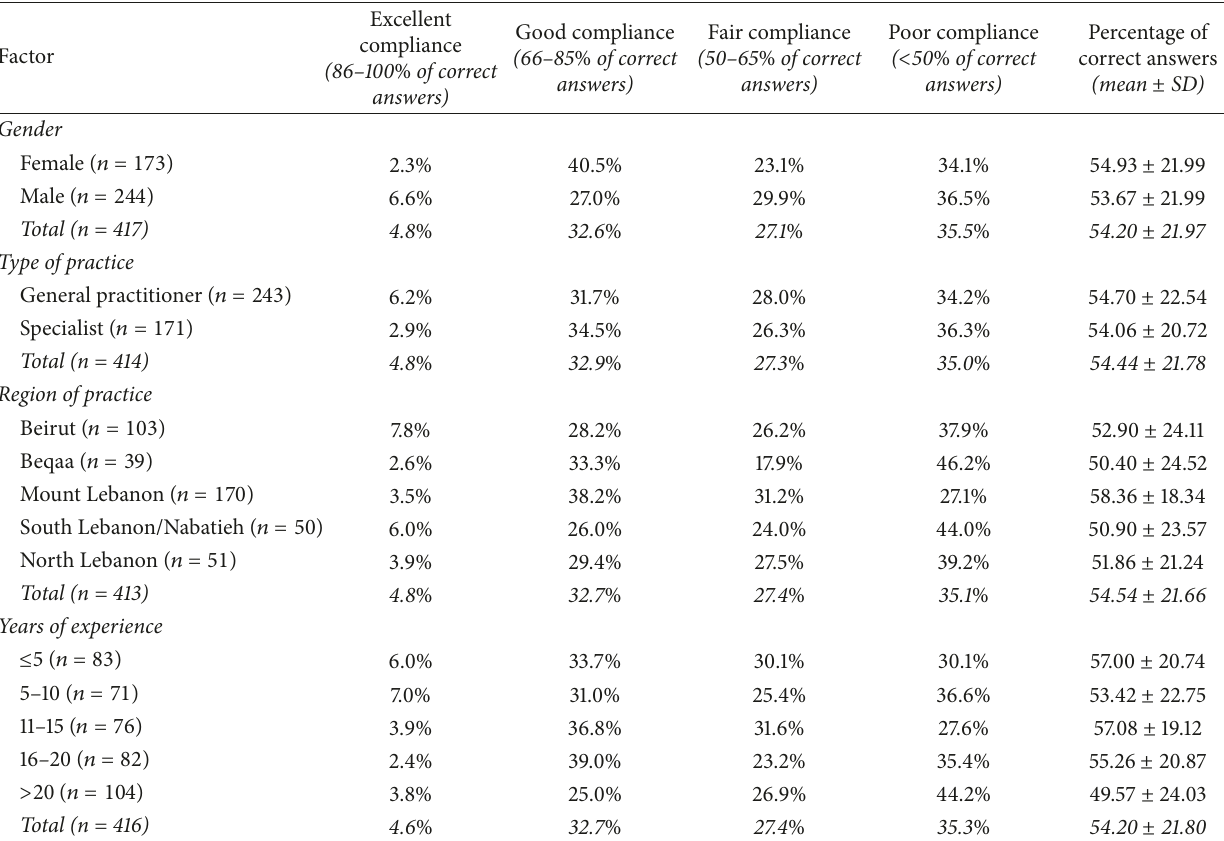
Table 5: Levels of compliance with infection control practices in private dental clinics in Lebanon (2015) according to sociodemographic variables and work experience. The level of compliance is expressed as excellent, good, fair, or poor according to the percentage of correct answers to the questions listed in the Appendix. The difference in the total number of respondents for each variable is due to missing data in the filled-out questionnaire